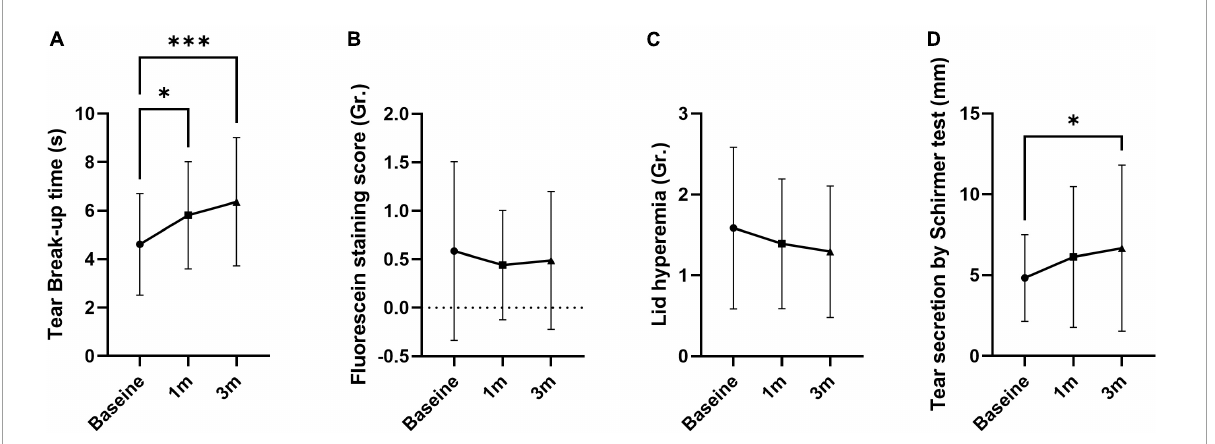
FIGURE1 The effect of MVG on objective signs of dry eye. (A) Tear break-up time was improved. (B,C) Fluorescein staining score and lid hyperemia were not changed. (D) Tear secretion by Schirmer test was improved. Data presented as mean ± SD. ∗ p < 0.05, ∗∗ p < 0.01, and ∗∗∗ p < 0.001.